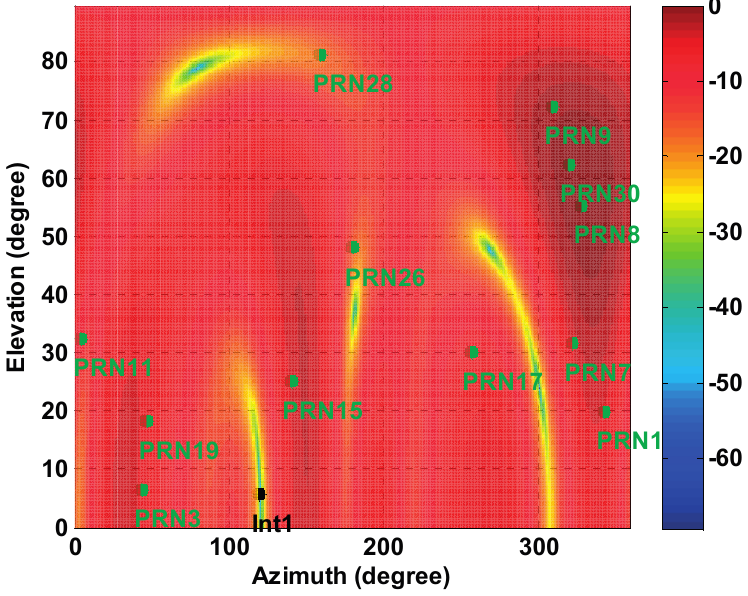
Figure 5. Normalized antenna array gain pattern at the interference